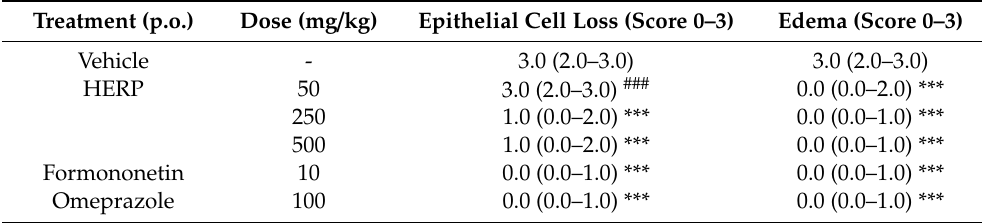
Data are presented as medians with minimum and maximal scores in brackets; di ff erences were identified using Kruskal–Wallis followed by Dunn’s test; *** p < 0.001 vs. vehicle group; and ### p < 0.001 vs. HERP groups at 250 and 500 mg / kg; three histological sections from each animal, n = 6 /